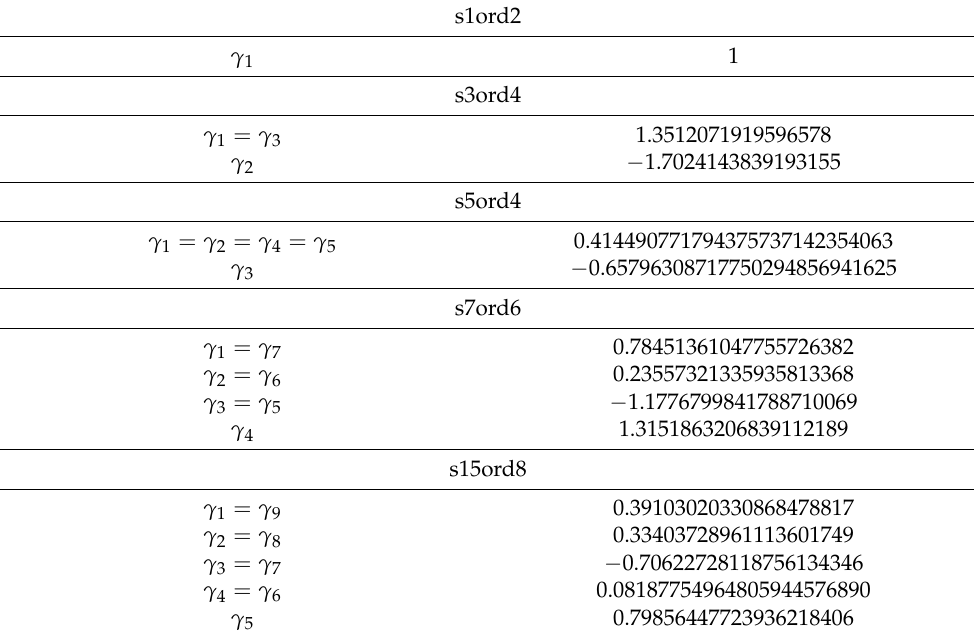
Table 1. Coefficients for composition schemes of different orders and number of